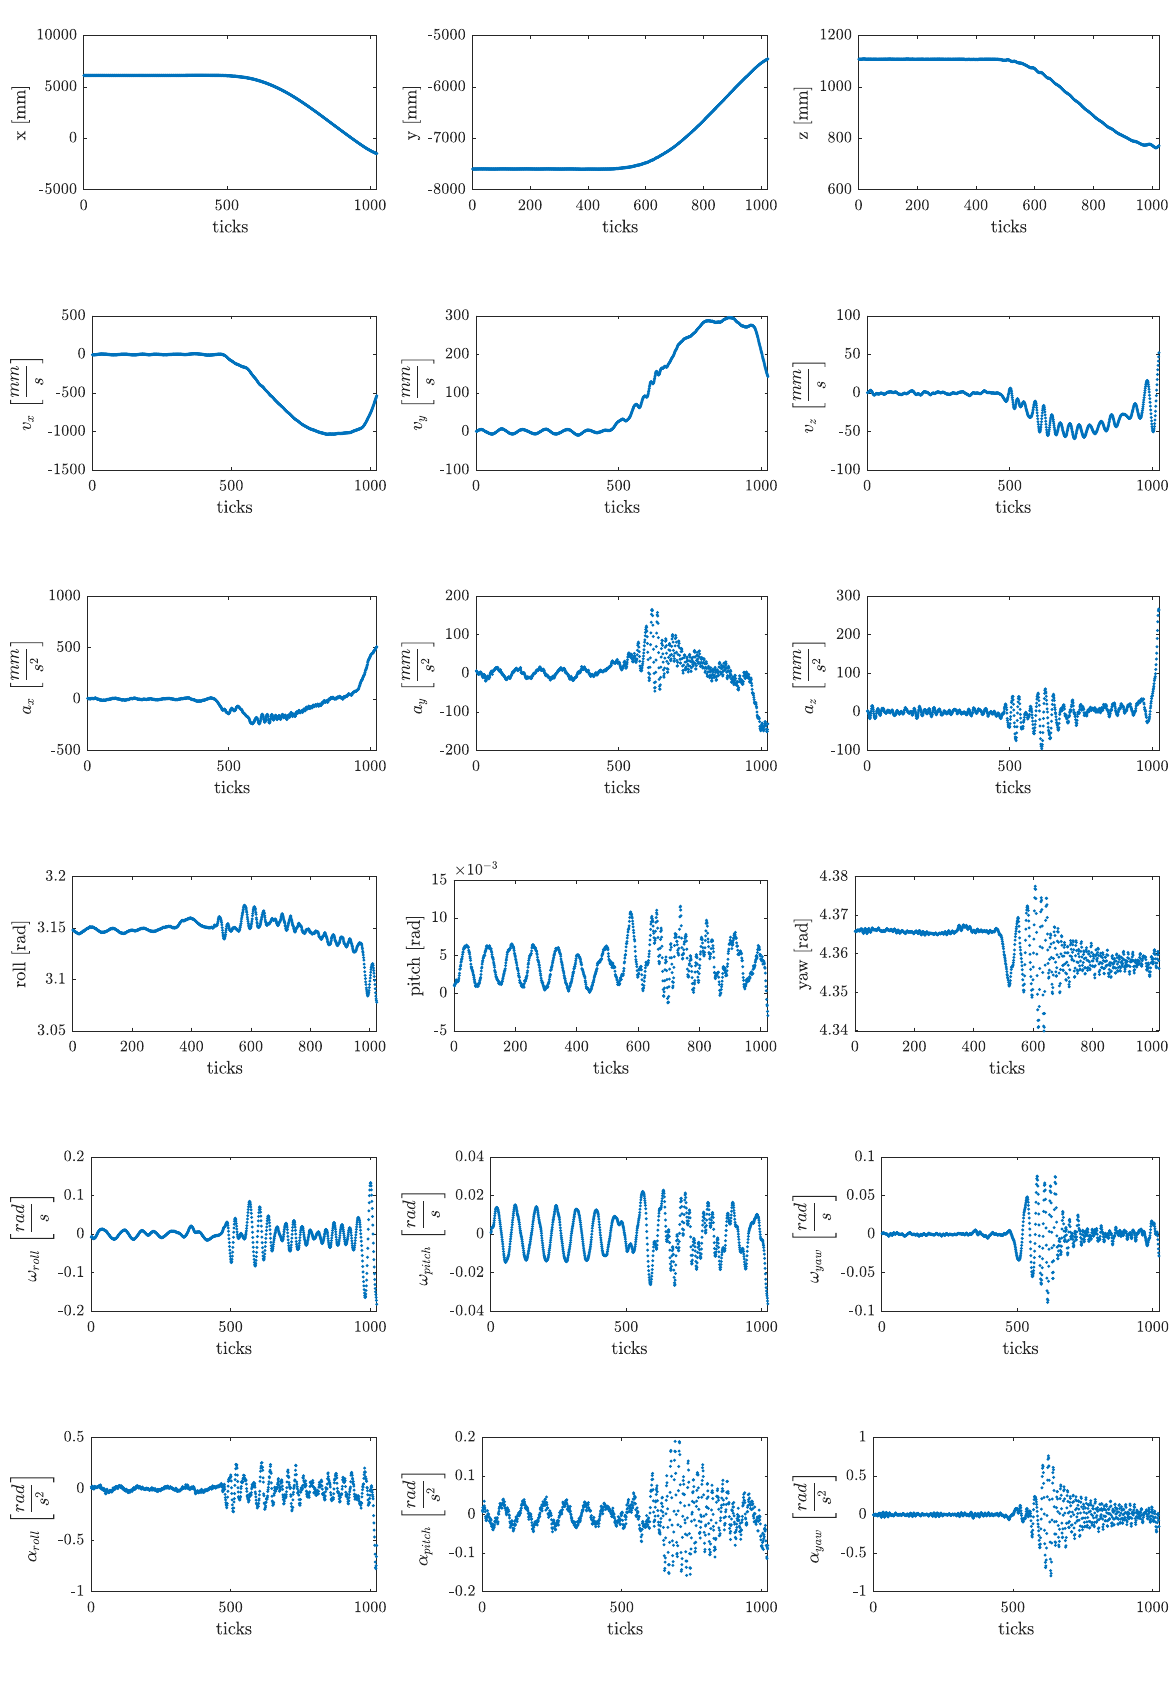
Figure 5. Results of the state vector from the